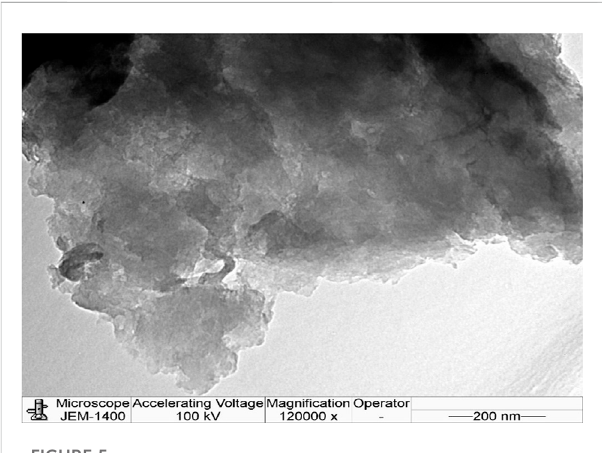
FIGURE 3 XRD diffractograms of Graphite oxide (GRO) and highly reduced graphene oxide (HRG).